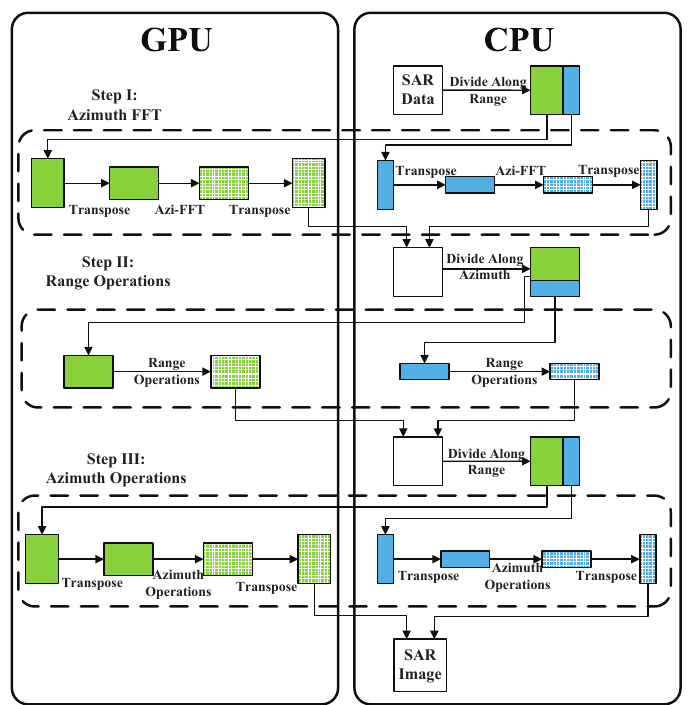
Figure 4. Bi-direction partitioning based multiple devices parallel